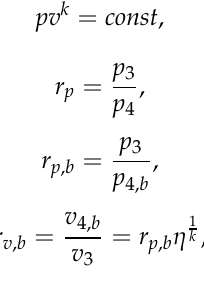
Figure 2. Losses during the admission phase are represented in the real path from A to 3’ (in green line) while losses during the discharge phases are shown in the paths from 5’ to B’ and from 5” to B” (in green lines). Under real working conditions, losses due to thermodynamic irreversibility can be evaluated in the real expansion phase from 3’ to 4’ ; obviously, these real expansion processes follow the equation p · v n = const , where n is the polytropic index of the working